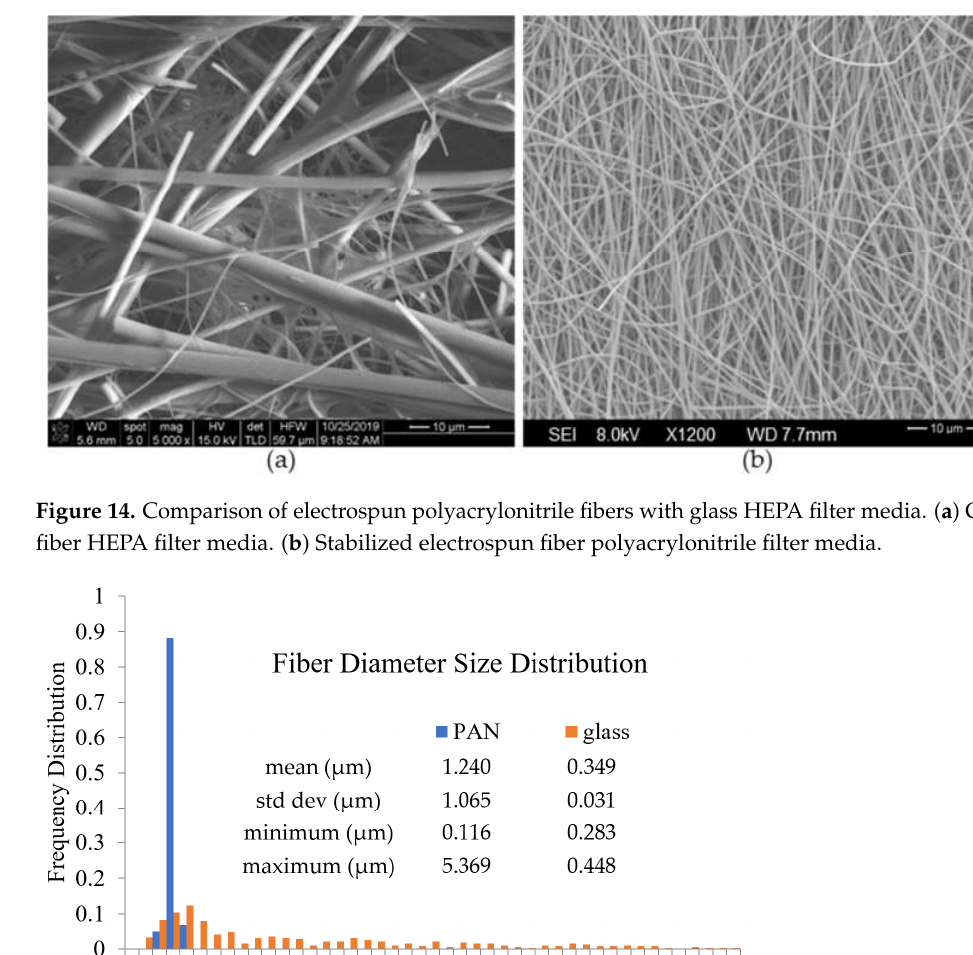
Figure 14. Comparison of electrospun polyacrylonitrile fibers with glass HEPA filter media. ( a ) Glass fiber HEPA filter media. ( b ) Stabilized electrospun fiber polyacrylonitrile filter media.